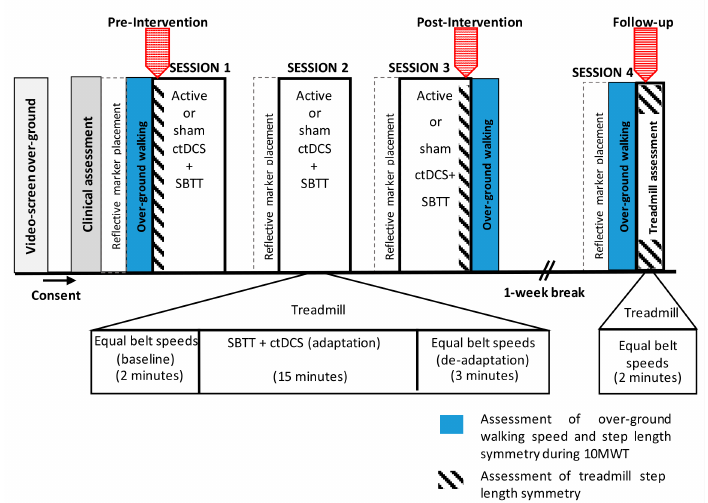
Figure 1. An illustration of the study